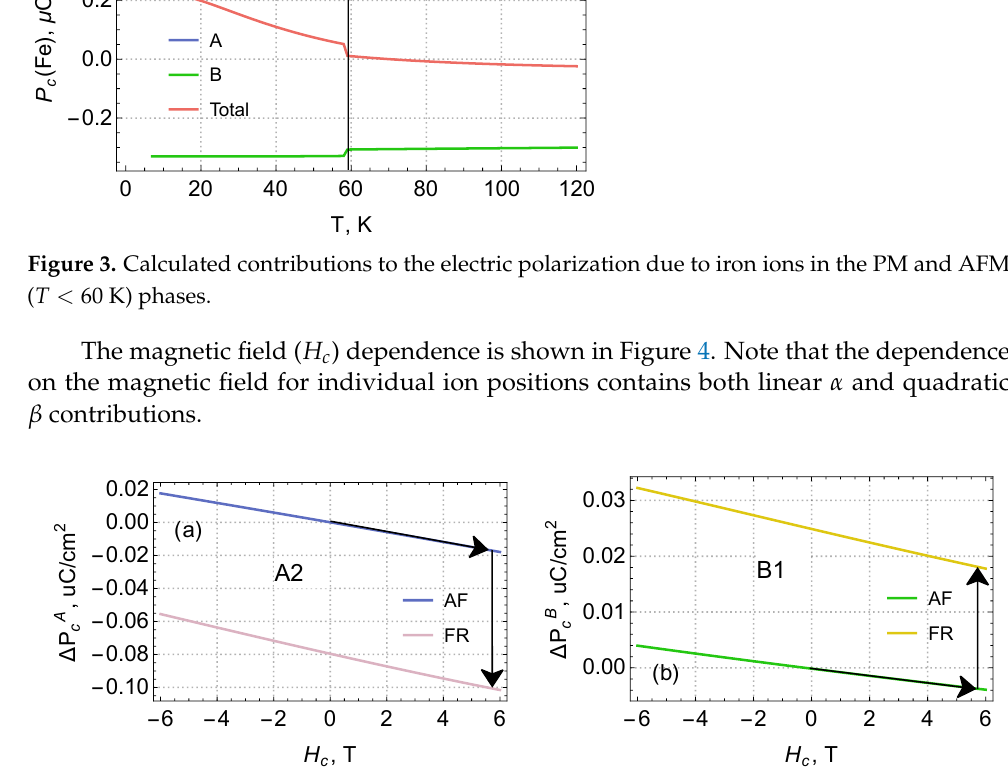
Figure 4. Field dependence of the electric polarization at positions A2 ( a ) and B1 ( b ) (see Figure 1) in the antiferromagnetic and ferrimagnetic phases. Calculated magnetoelectric coupling coeffi- ( A ) = − 29.61 µ C/T, β ( A ) = − 0.06 µ C/T 2 , α ( A ) = − 38.55 µ C/T, β ( A ) = 0.29 µ C/T 2 ; cients are: α FR FR AF AF ( B ) = − 6.57 µ C/T, β ( B ) = 0.05 µ C/T 2 , α ( B ) = − 12.12 µ C/T, β ( B ) = 0.04 µ C / T 2 at temperature α FR FR AF AF T = 55 K . Black arrows demonstrate the path of the AFM-FRM phase